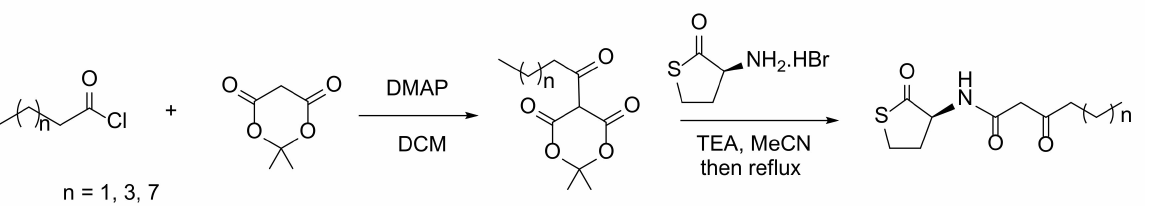
Scheme 2. Synthetic approach towards acyl homocysteine thiolactones.